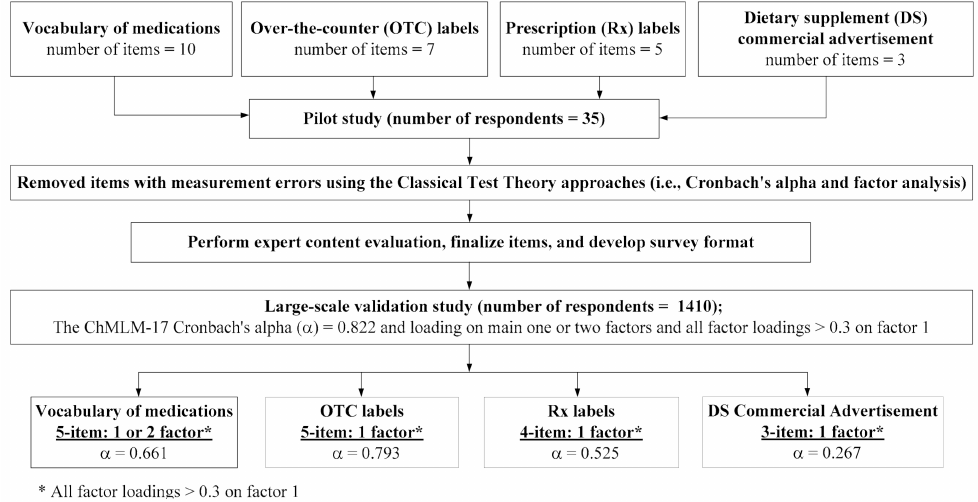
Figure 2. Item reduction process and its psychometric properties of the